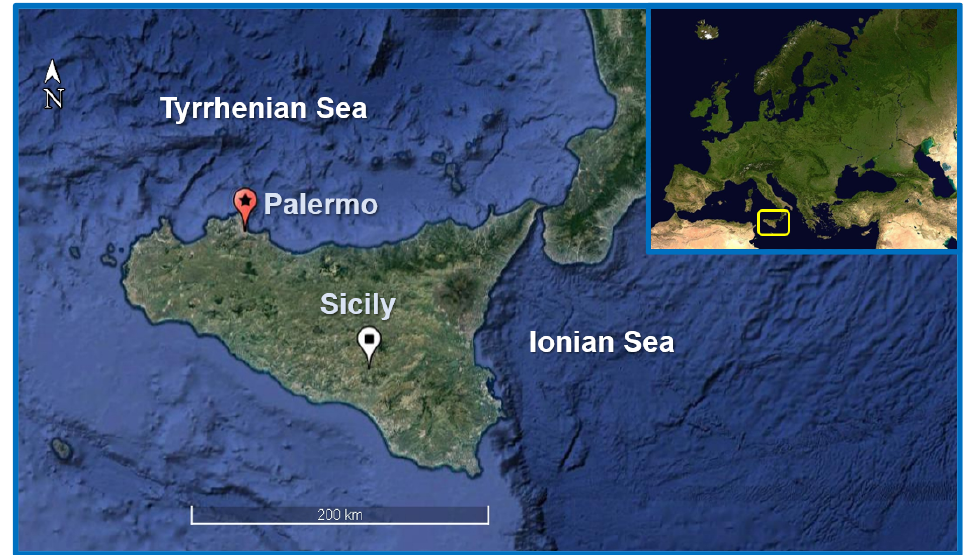
Figure 1. Map showing the position of Sicily in the south of Italy (edited from Google